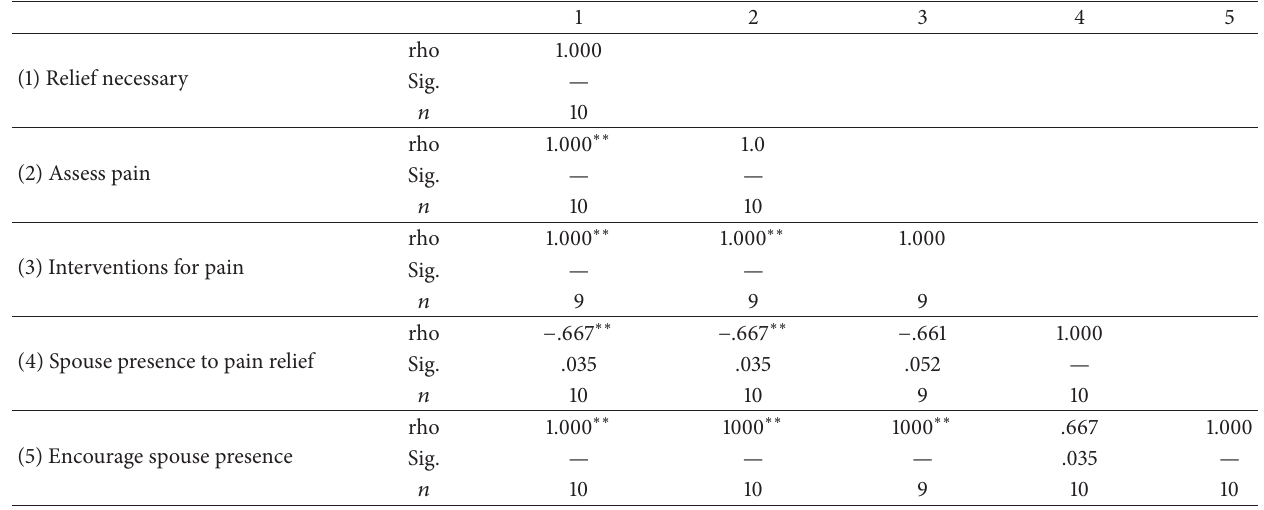
Table 4: Spearman’s rho items correlations of Abuja Instrument for Midwives